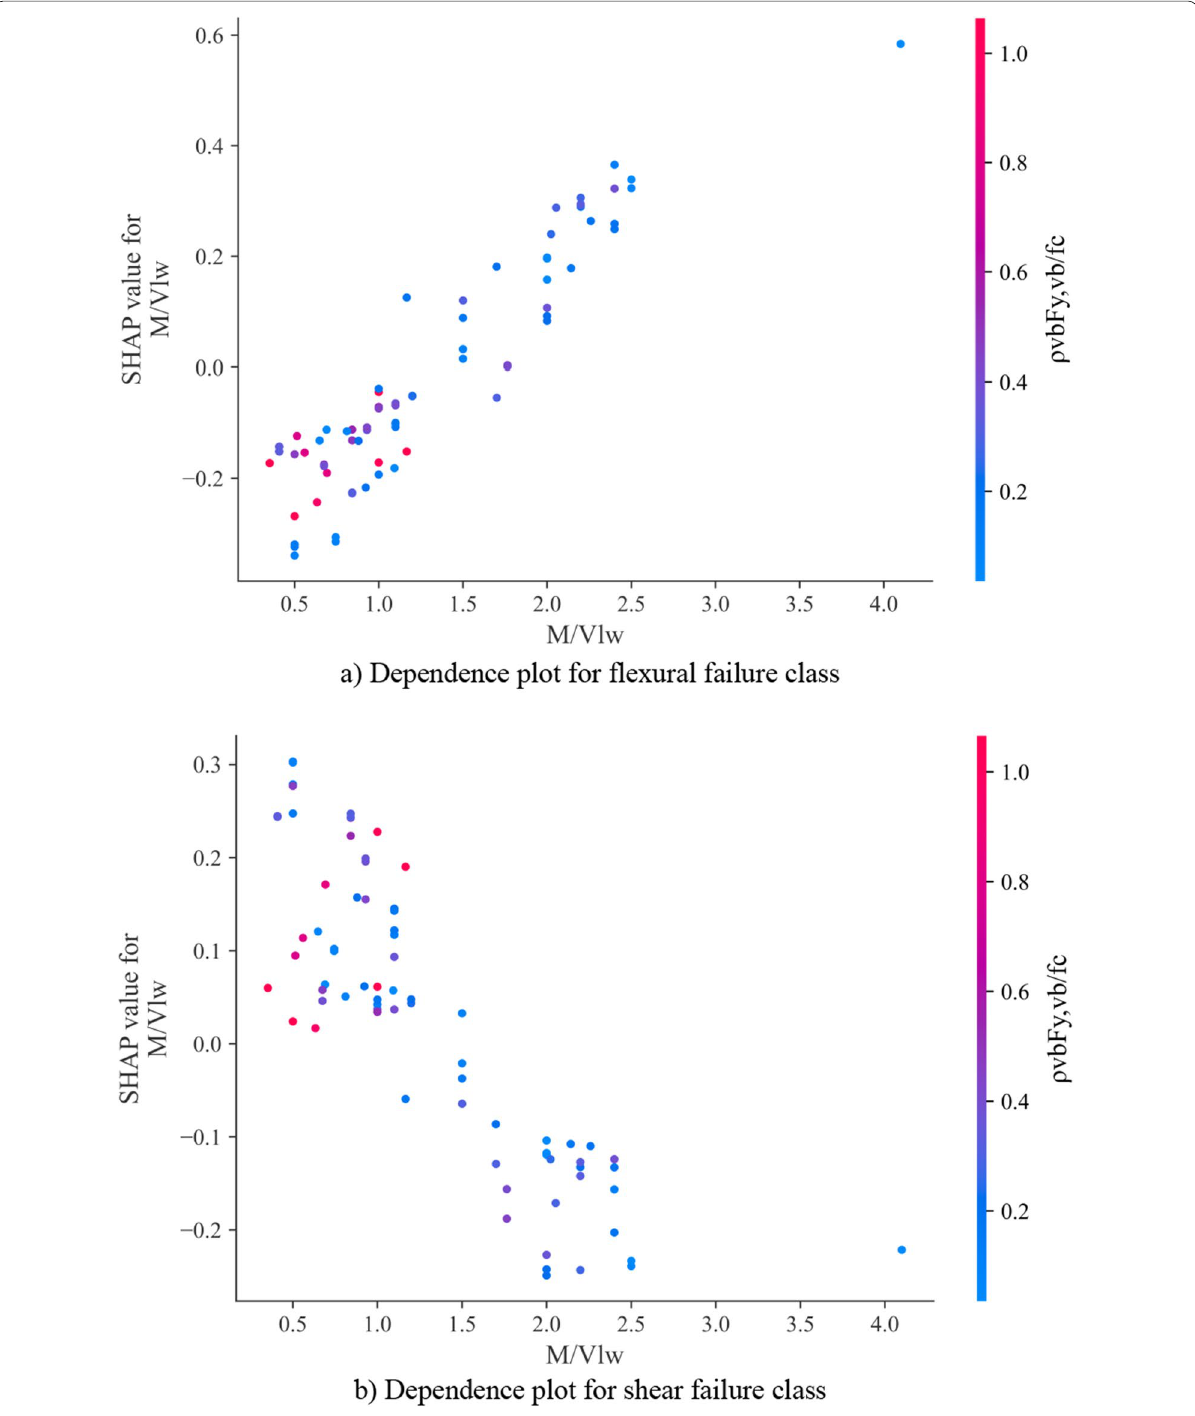
Fig. 13 SHAP dependency analysis. a Dependence plot for flexural failure class. b Dependence plot for shear failure